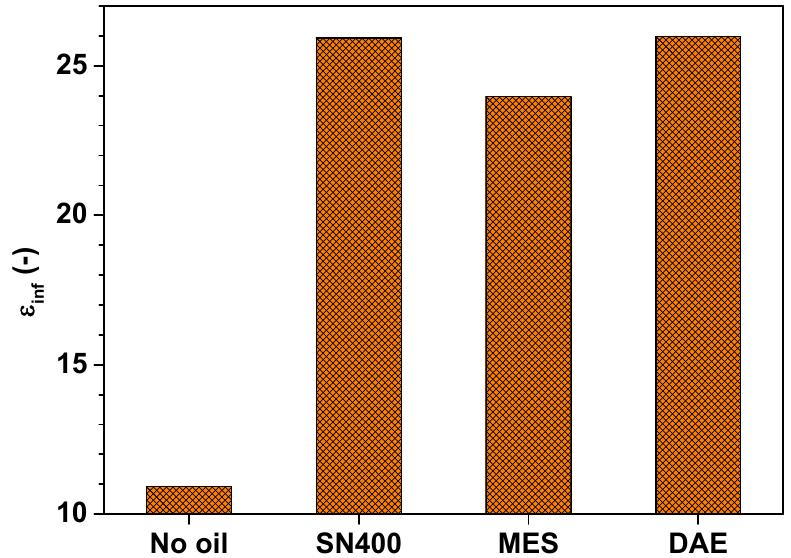
Figure 11. Infinite ‐ frequency dielectric permittivity 𝜀 (cid:2919)(cid:2924)(cid:2916) of the SBR samples determined by means of simultaneous mechanical and dielectric measurements at 24 °C under a static force of 10 N.